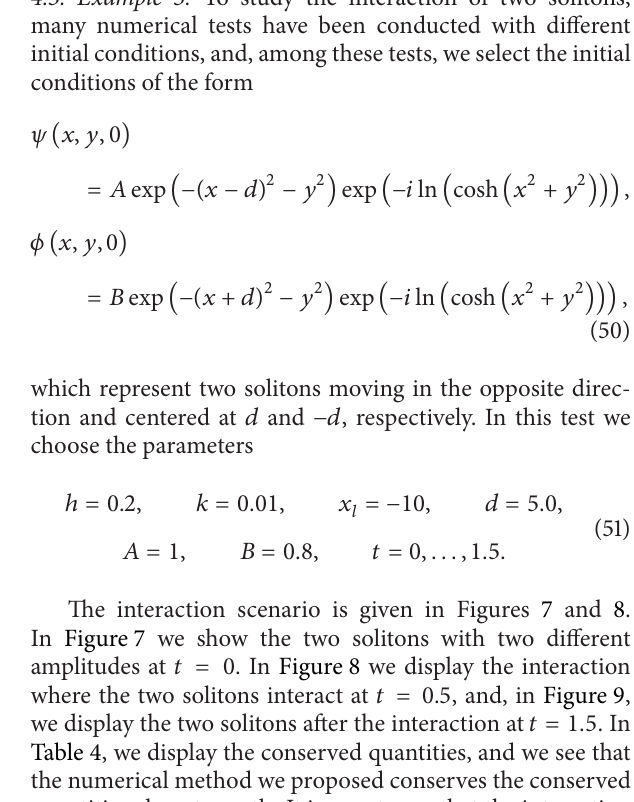
Table 3: Single soliton with 𝜎 = 1/12 .